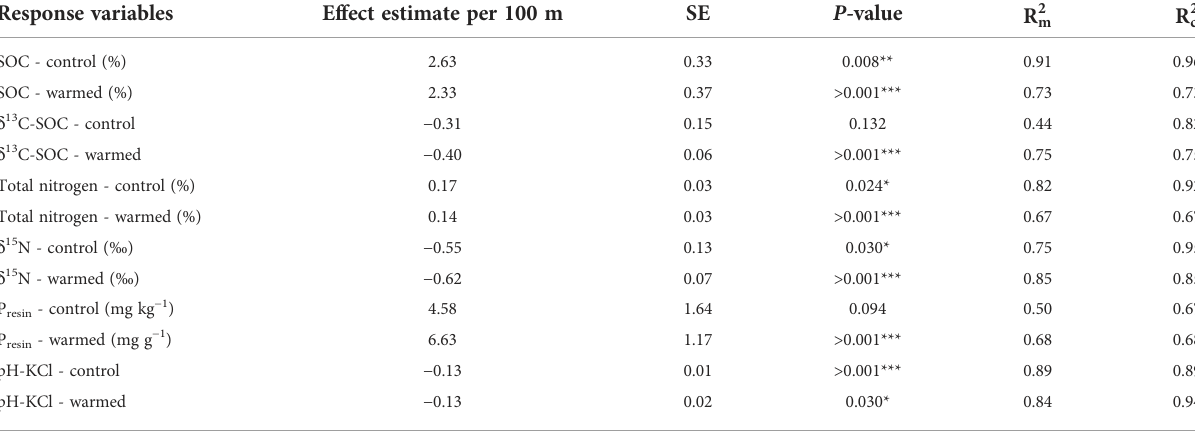
TABLE 3 Fixed effect estimates of elevation (per 100 m) following in situ soil warming for response variables: organic carbon (SOC), d 13 C-SOC, soil total nitrogen (STN), d 15 N, bio-available P (P resin ), and pH. Response